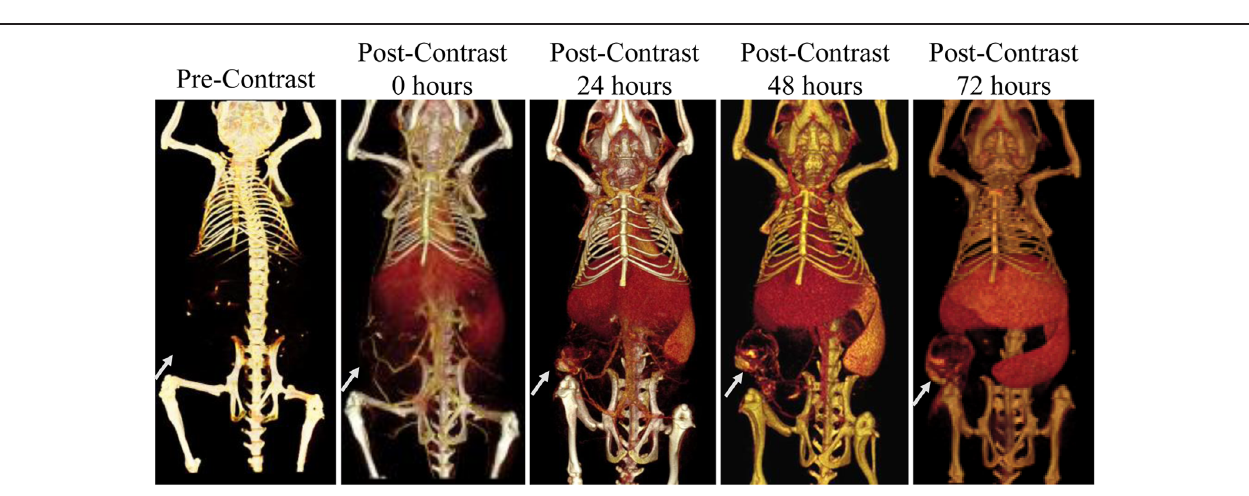
nanoparticle dynamic biodistribution and tumor accumulation for a mouse injected with liposomal iodine (Ghaghada et al., 2011). Immediately after liposome injection, blood vessels are